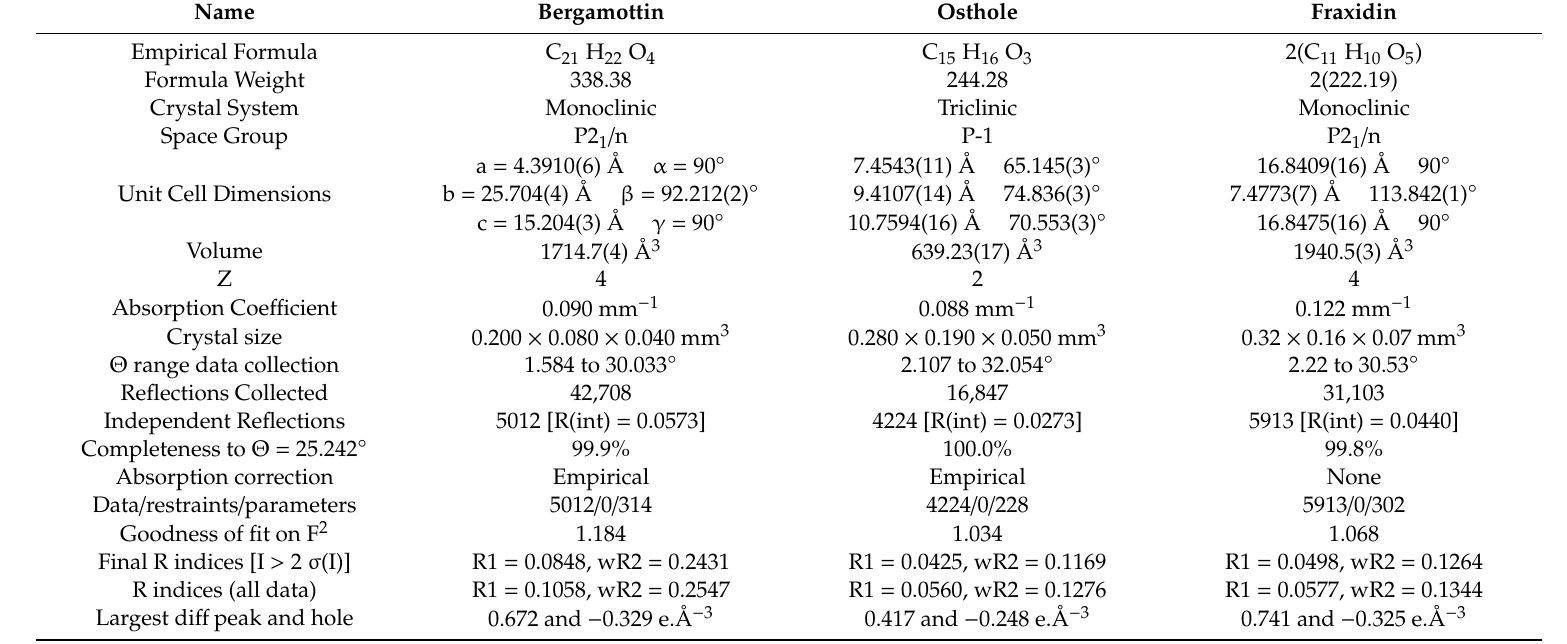
Table 1. X-ray Data for Bergamottin, Osthole and Fraxidin. All data were collected at Temperature = 125(2) K and (Mo) λ = 0.71073